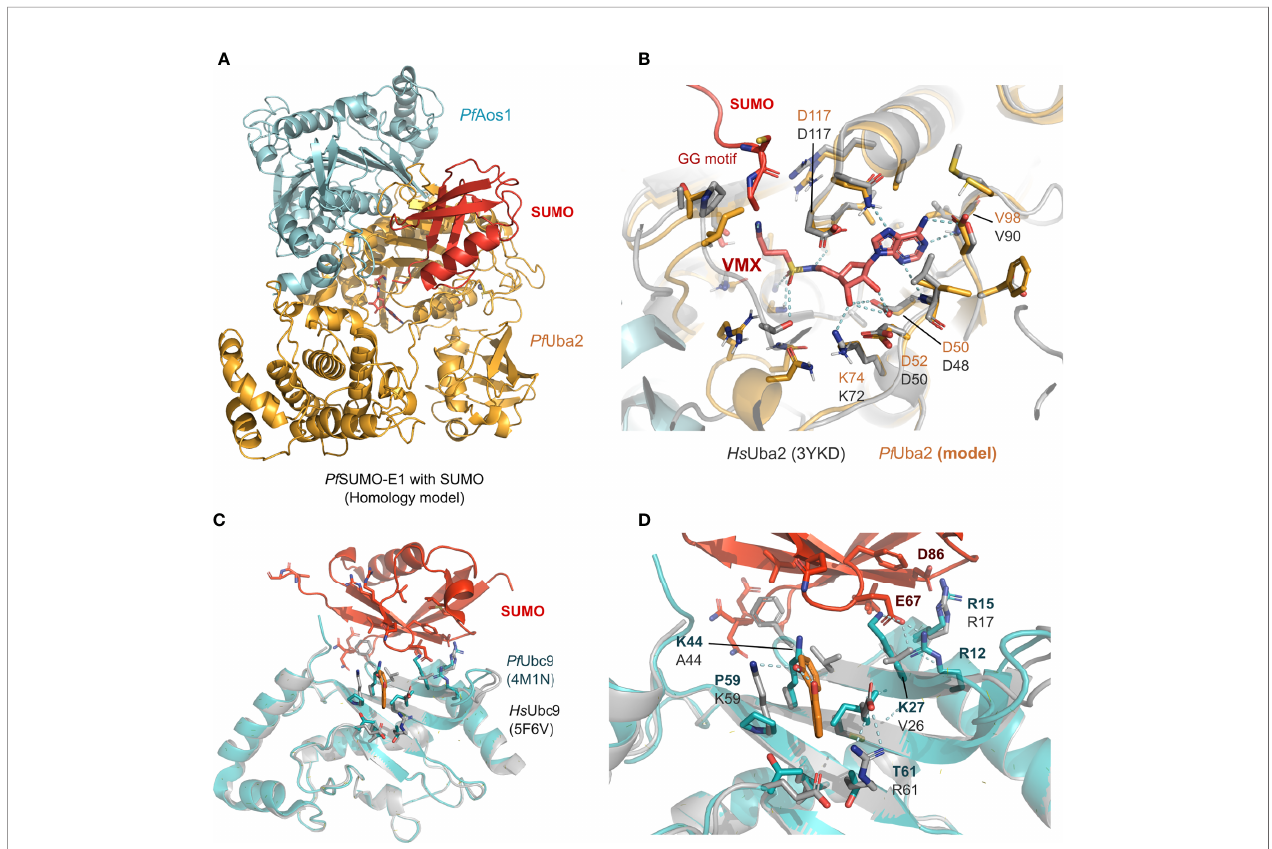
FIGURE 2 | Structural models of the SUMO machinery highlight their folding conservation and high similarity in the active site. (A) overview of Pf SUMO-E1 complex modeled after the human homolog, where the interface between Pf Aos1 (cyan) and Pf Uba2 (orange) can be seen together with the interaction surface of SUMO